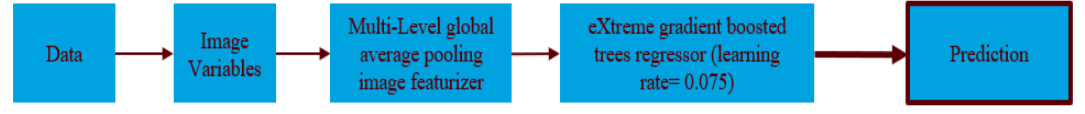
Figure 13. Supervised model workflow.